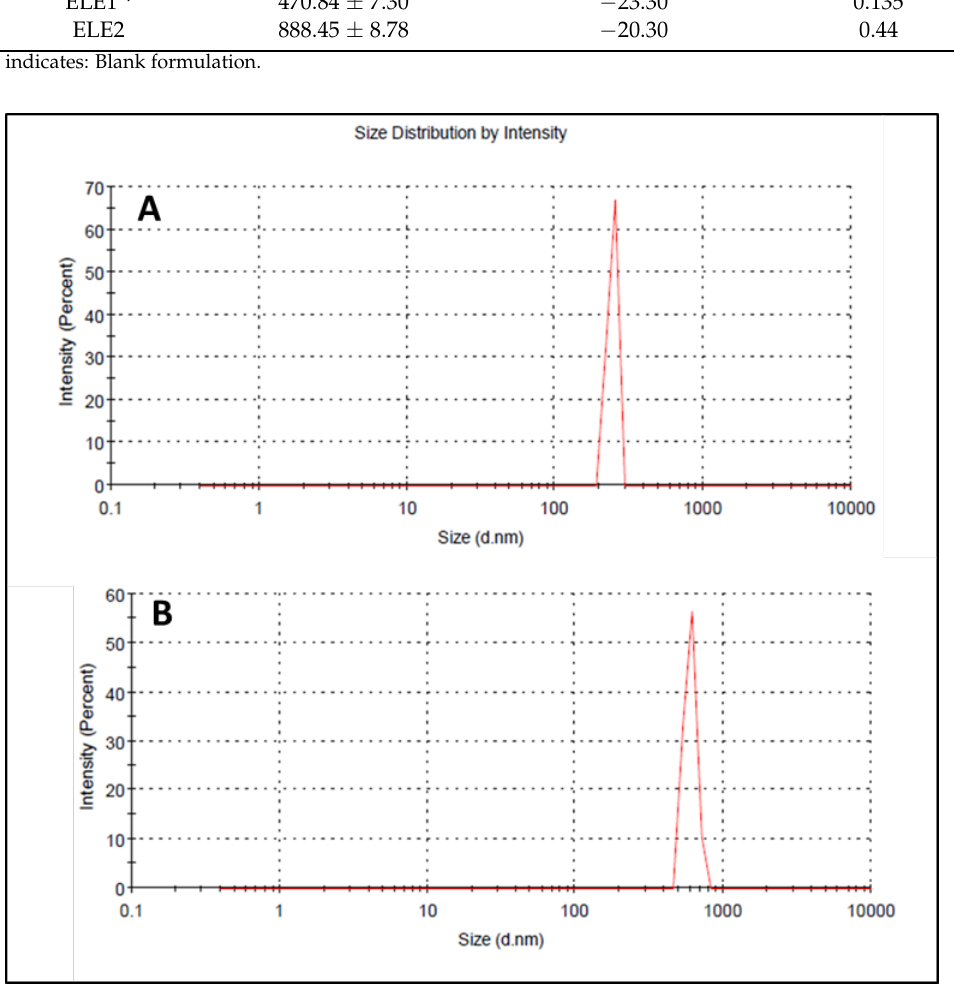
Table 5. Droplet size, zeta potential, and PDI of ELE1 and ELE2 formulations. Formulations